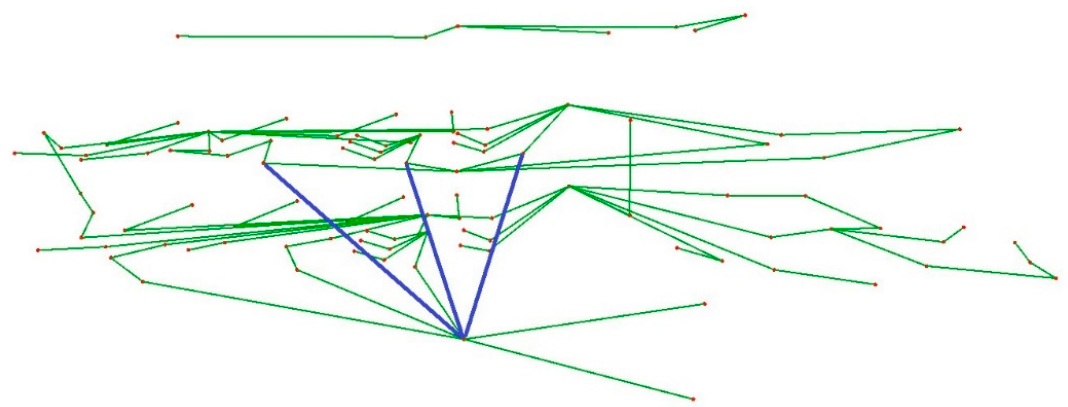
Figure 9. Navigation network derived from the IFC dataset using the first method.